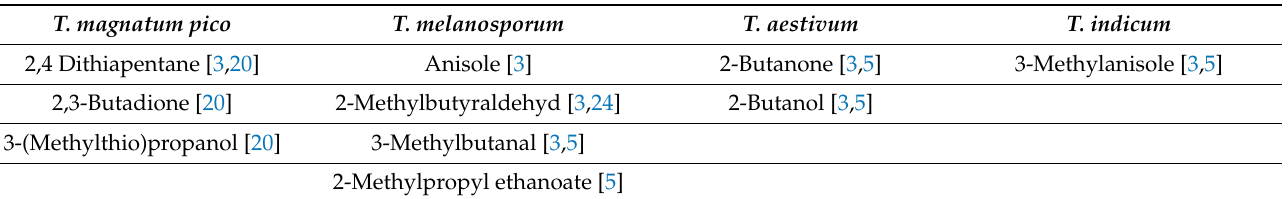
Table 1. Specific aroma components of different truffle varieties according to